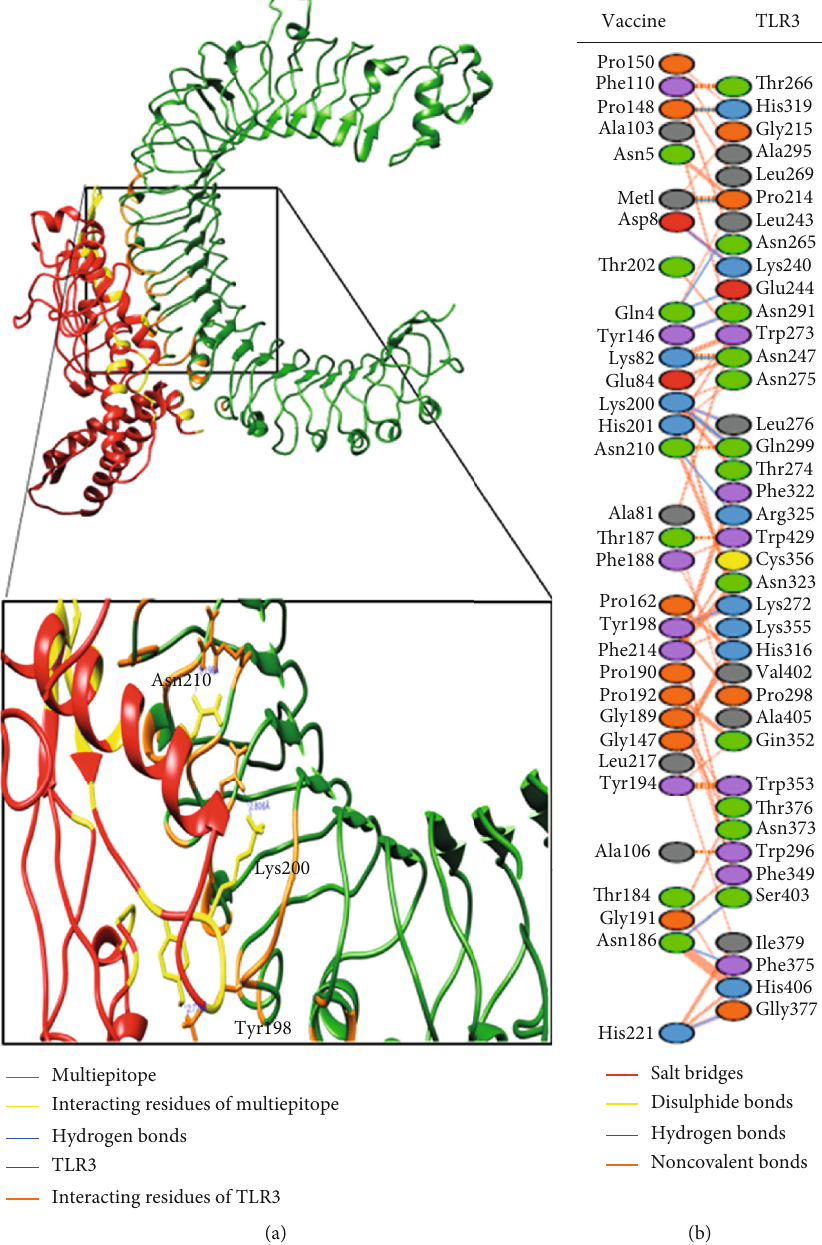
Figure 3: (a) Here, we show the interaction pose of a representative complex of the vaccine-TLR3 re fi ned cluster. The designed vaccine is colored red while the TLR3 structure is colored dark green. The interacting residues are focused, and some interchain hydrogen bonds are highlighted. Residues Tyr198, Lys200, and Asn210 of the vaccine construct participated in hydrogen bond formation with some residues in the TLR3 structure. (b) Interacting residues as well as bonding interactions between the vaccine and TLR3 protein